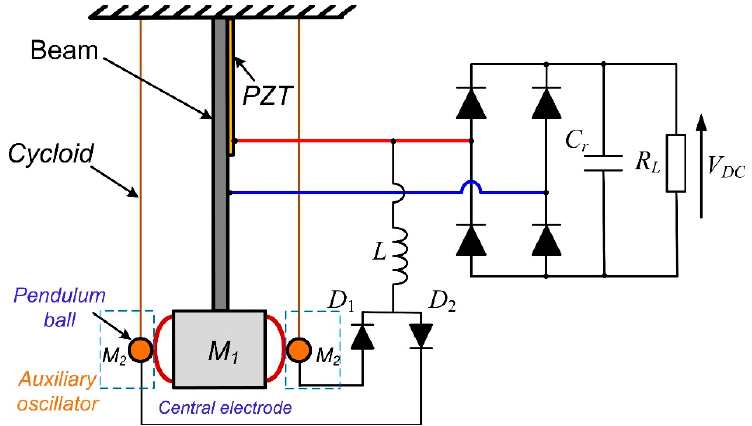
Figure 2. Piezoelectric generator with the proposed adaptive mechanical switch.